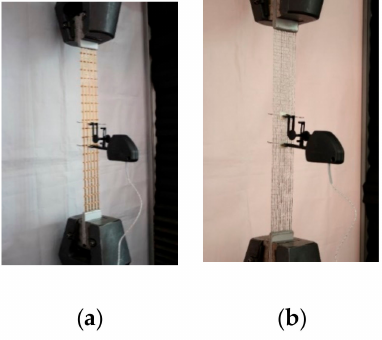
Figure 3. Test setup: ( a ) PBO and ( b ) Steel, Basalt bare textiles.